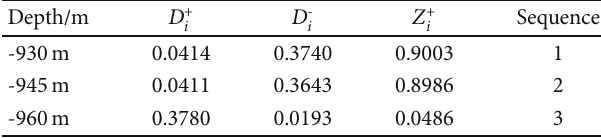
Table 10: Euclidean distance and closeness